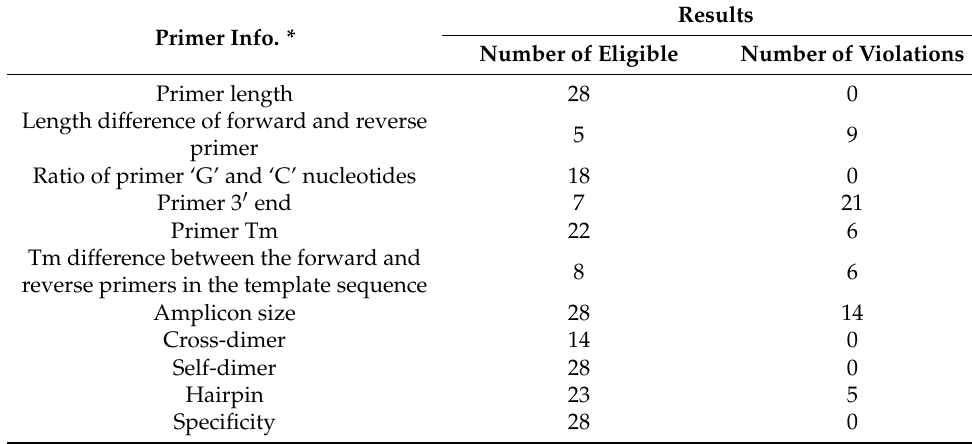
Table 6. Design results of mutagenic primers combined with REHUNT. The number of iterations and population size were set to 500 and 50,